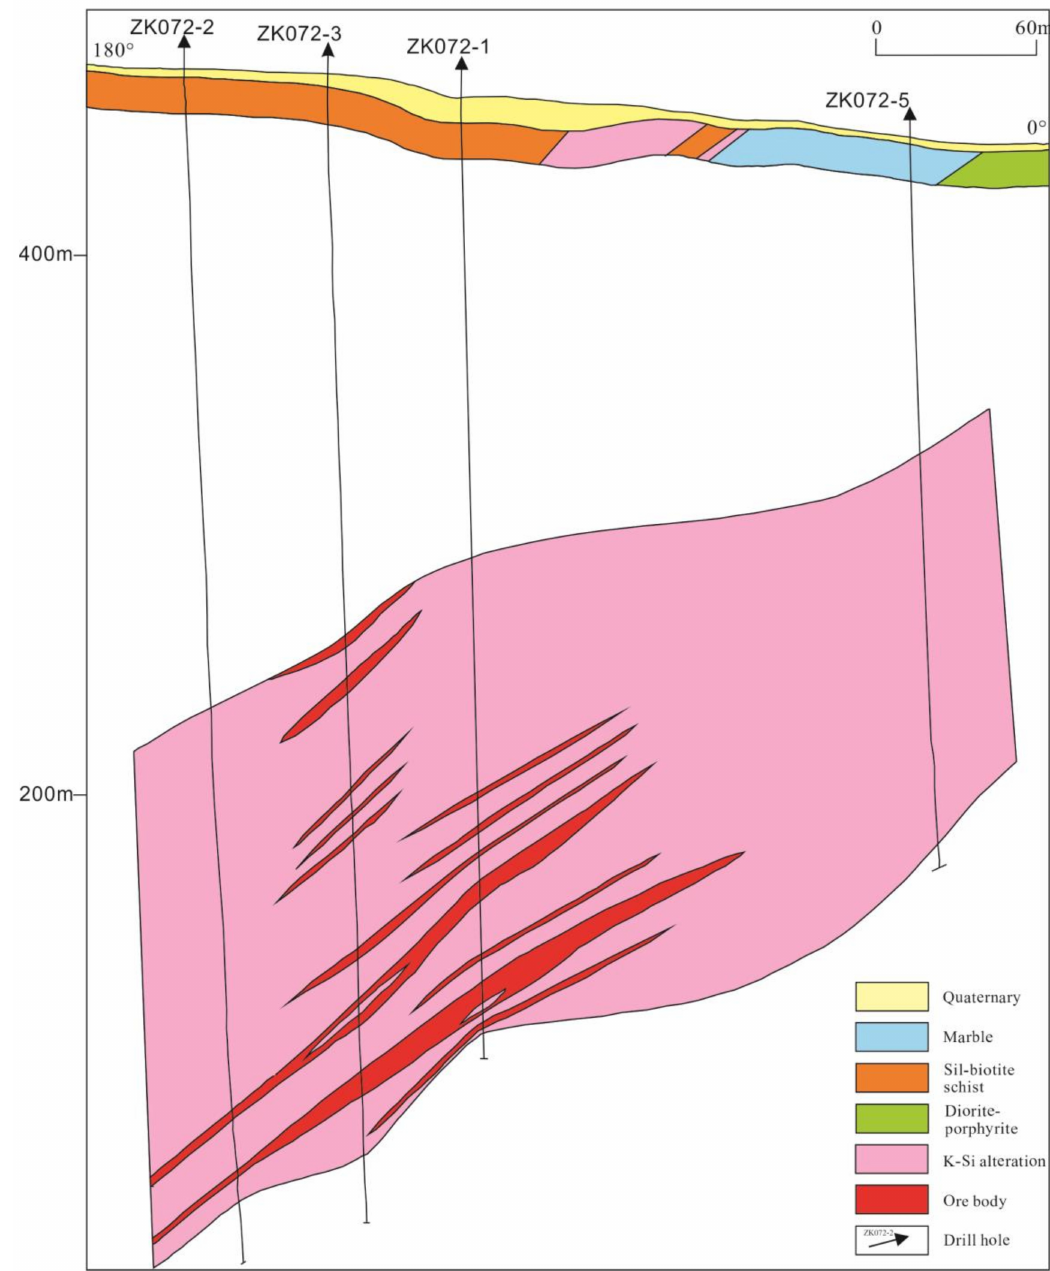
Figure 4. Generalized geological sections of Lode 60 in the Baiyun deposit (modified after